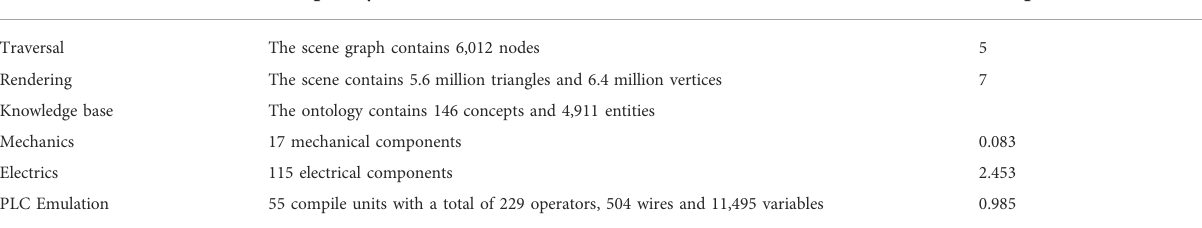
TABLE 1 Evaluation parameters and results.